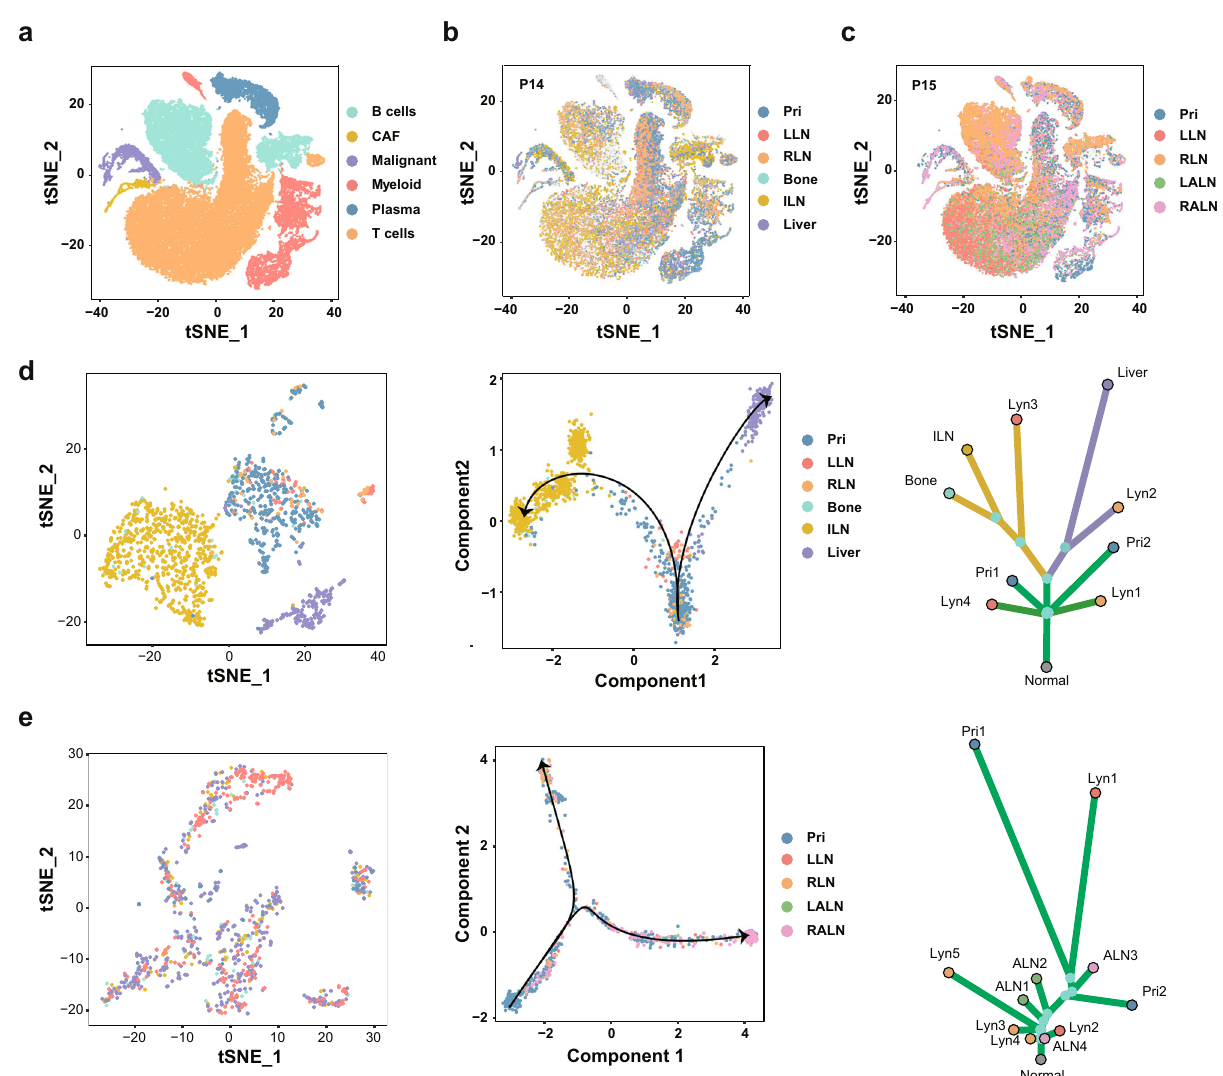
Fig. 4 | Lymphatic and hematogenous evolution models revealed by scRNA- seq. a The t-SNE plot showing the unsupervised clustering results with cell types annotated. b The t-SNE plot showing the sample locations of single cells from P14. c The t-SNE plot showing the sample locations of single cells from P15. d , e PseudotimetrajectoryanalysisoftumourcellsfromP14( d )andP15( e ).Theleft panel shows the t-SNE plot of tumour cells coloured according to the sample